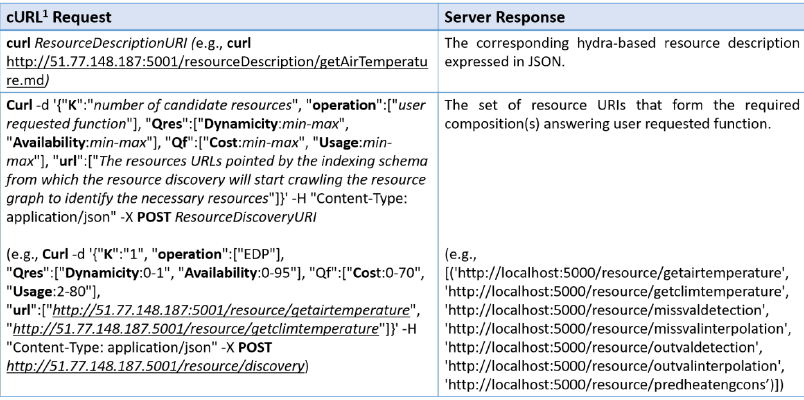
Figure 8. Requests vs Responses in